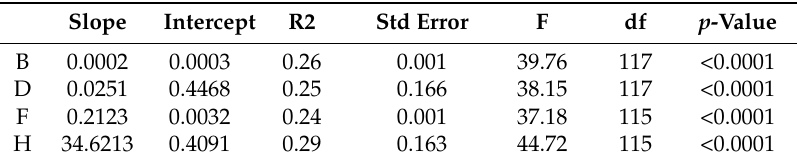
Table 1. Parameter estimates, R-square values and significance levels from linear regressions for the four lower panels in Figure